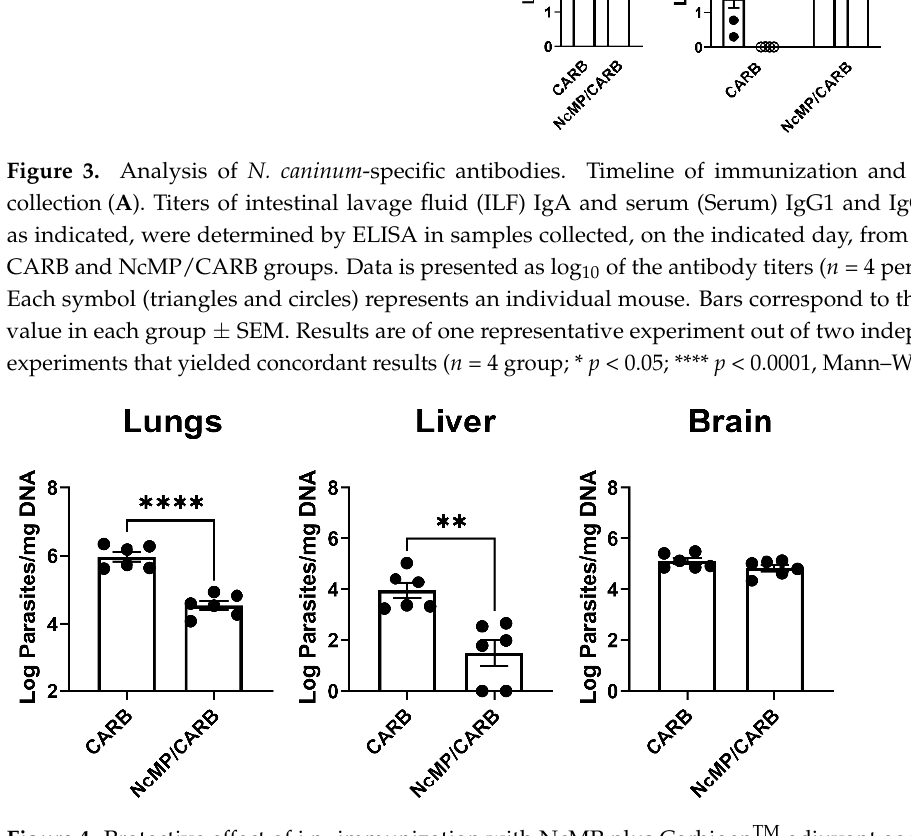
Figure 4. Protective effect of i.n. immunization with NcMP plus Carbigen TM adjuvant against i.p.